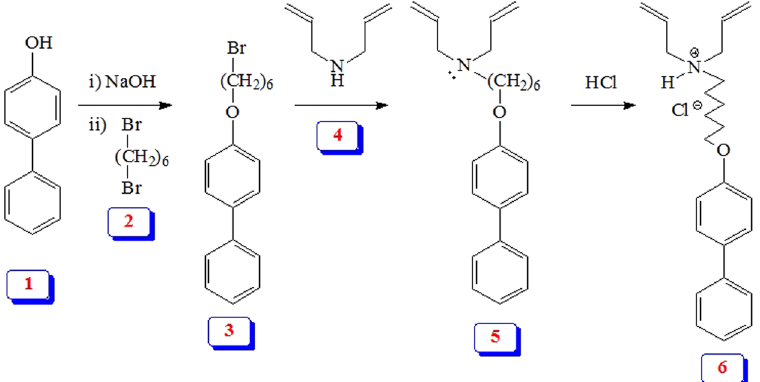
Figure 1. Synthesis of hydrophobic monomer 6